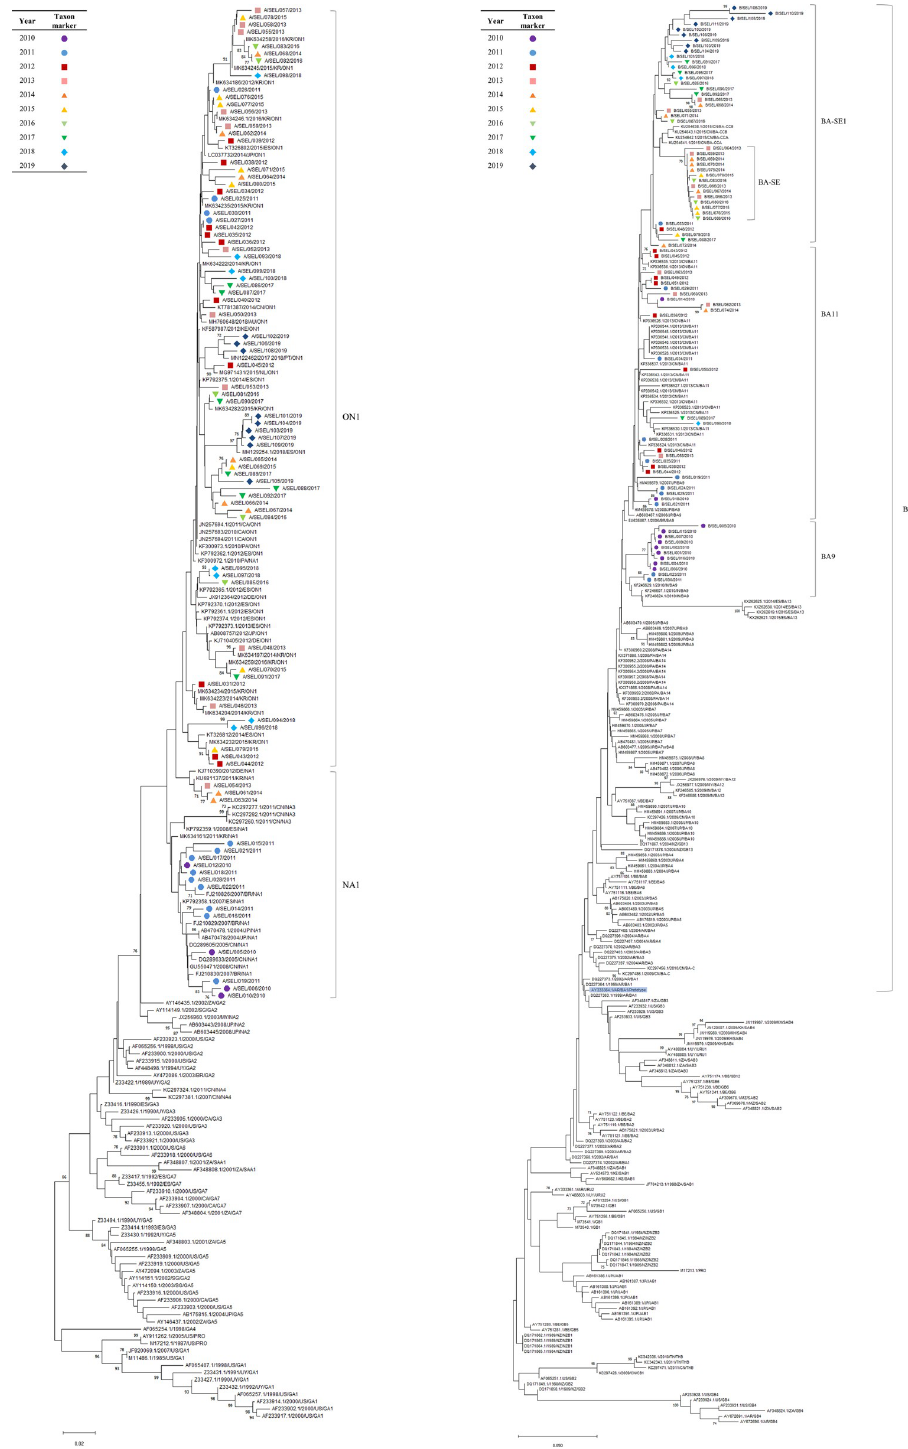
Fig 2. Neighbor-joining (NJ) phylogenetic tree of Seoul RSV-A and RSV-B strains. Phylogenetic trees based on the analysis of partial G gene sequence of RSV-positive samples from 2010–2019 in Seoul, (A) RSV-A and (B) RSV-B. Since the calculated average pairwise Jukes-Cantor distance was 0.08 and 0.06 for RSV-A and RSV-B, respectively, the data was suitable for building the NJ tree. The NJ trees were created using maximum composition likelihood and 1,000 bootstrap replicates by Mega X. Only bootstrap values � 70% are shown for each tree. Strains are labeled with